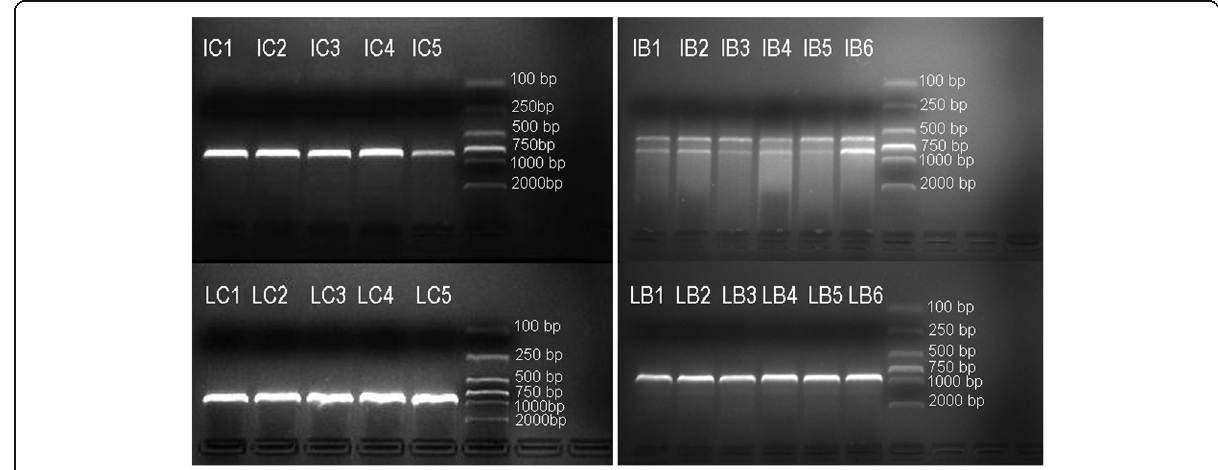
Fig. 1 Gel electrophoresis diagram of the PCR products amplified from 11 sampling points on the basidiome (C1, C2, C3, C4, C5) and mycocecidium (B1, B2, B3, B4, B5, B6) of Squamanita mira (HKAS100826, holotype), as indicated on Fig. 6. I and L indicate ITS and LSU (nrLSU),